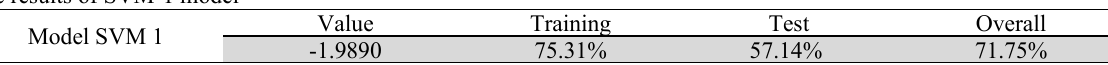
The results of SVM-1 model